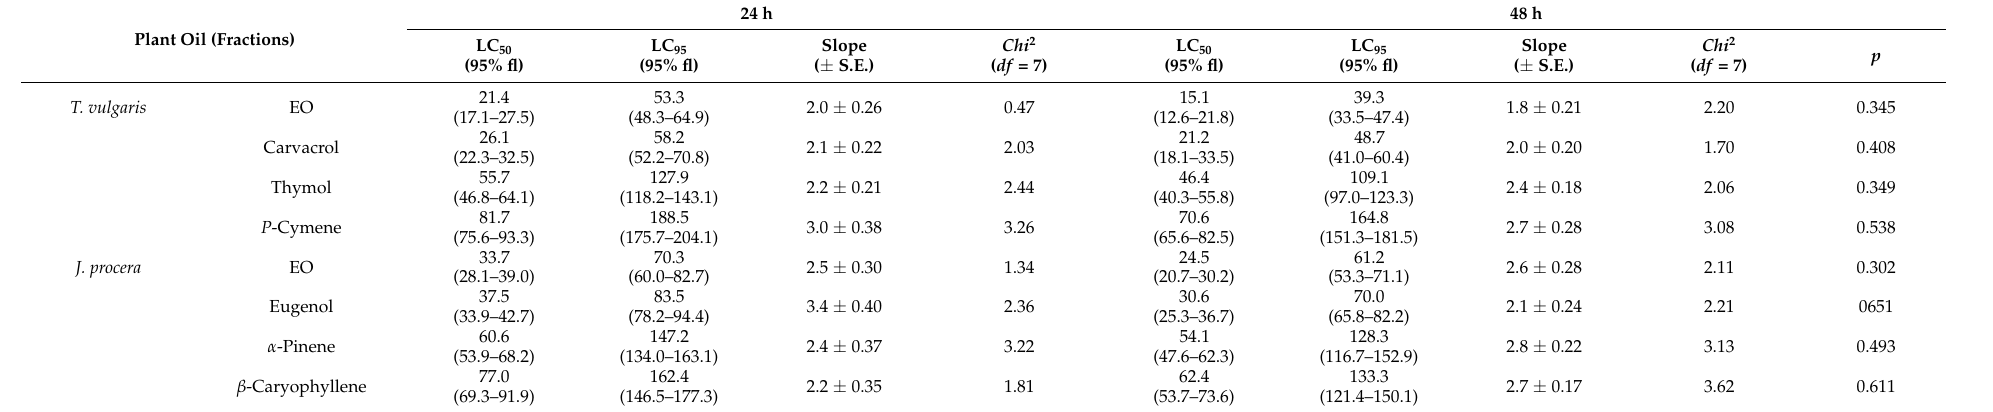
Table 2. Contact larvicidal activity ( µ L/cm 2 ) of the tested plant oils and their terpenes against T. granarium using the filter paper bioassay. Plant Oil (Fractions)